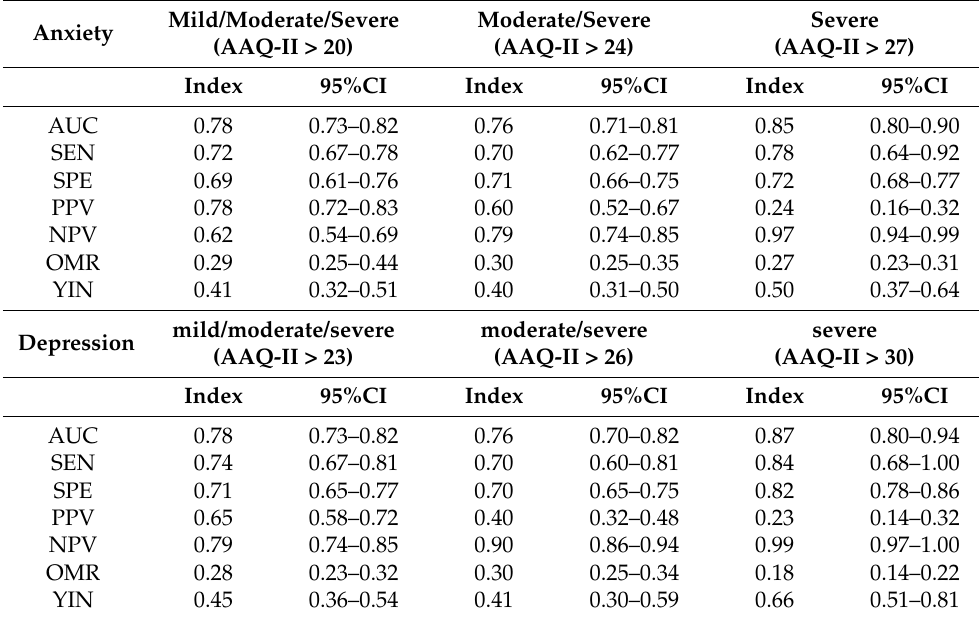
Table 5. Criterion validity coefficients of AAQ-II on HADS-anxiety and